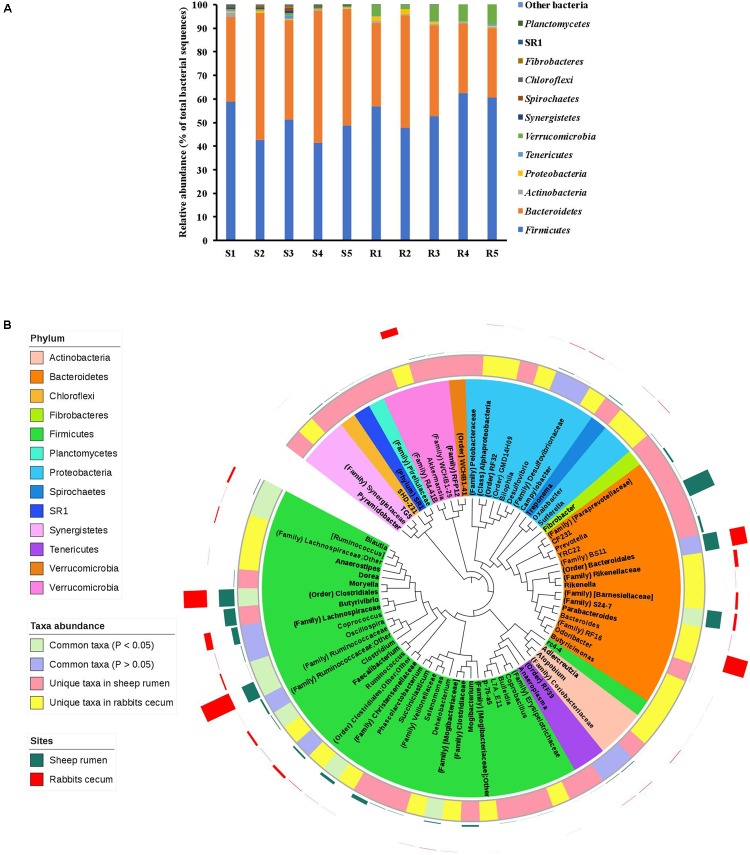
Comparison of the bacterial microbiota in the sheep rumen and the rabbit cecum. (A) The relative abundance of bacterial phyla; (B) A neighbor-joining phylogenetic tree of the representative sequences of the OTUs that were graphically displayed in the Interactive Tree of Life. S1–S5, the five sheep; R1–R5, the five blocks of rabbits.